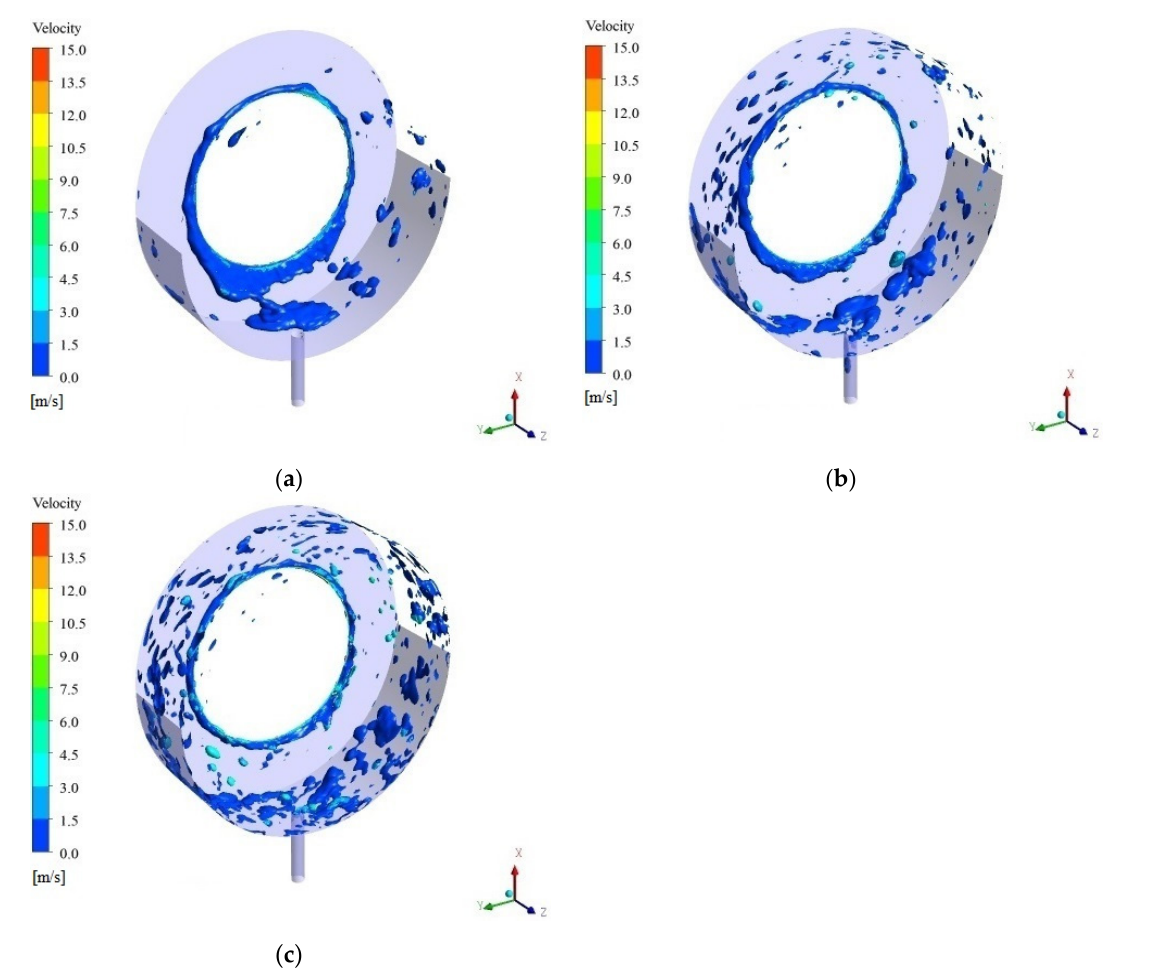
Figure 15. Distributions ( α = 0.25) and velocity fields at different rotor speeds in steady state: ( a ) n = 5000 rpm; ( b ) n = 10,000 rpm;( c ) n = 15,000 rpm.